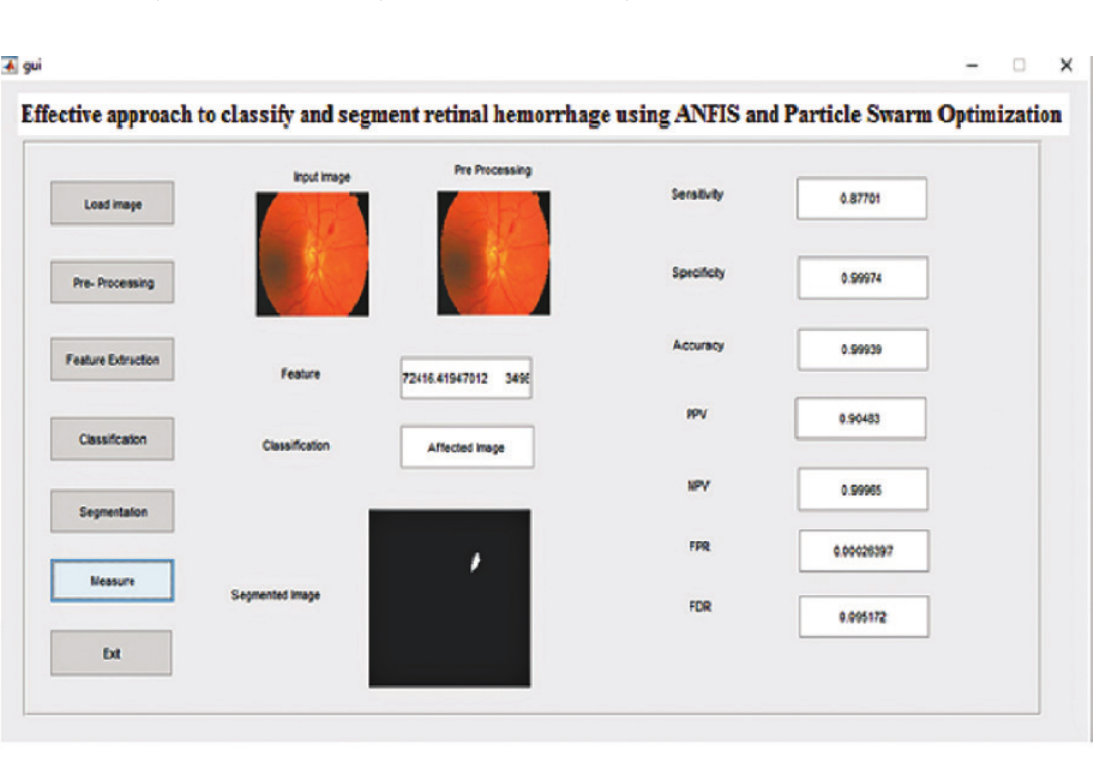
Figure 9: GUI for Segment Retinal Hemorrhage Detection